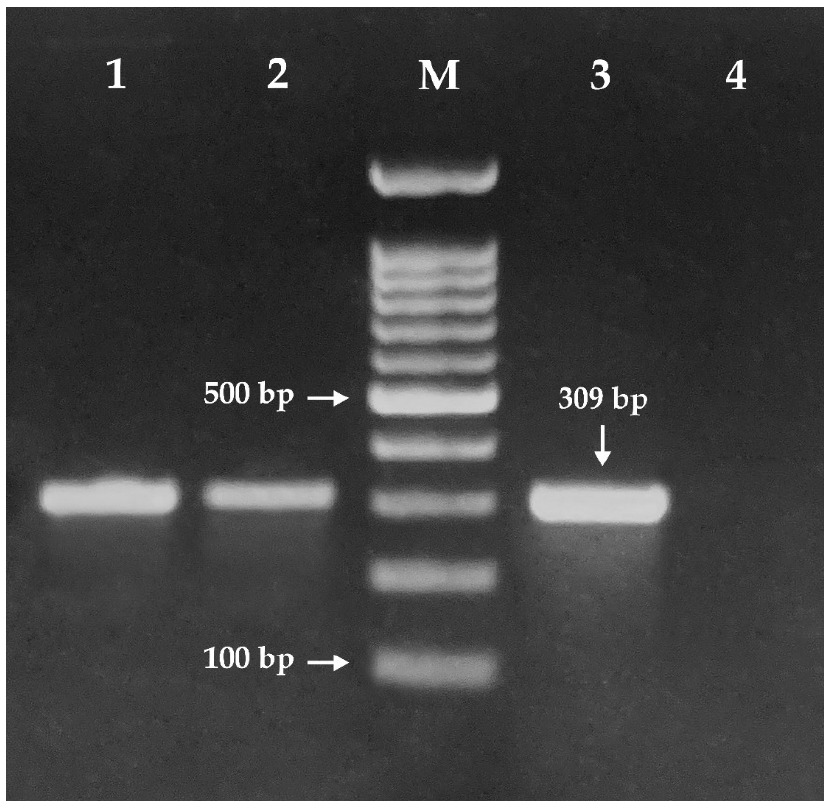
Figure 2. Agarose gel showing PCR amplification of mcr-1 gene in three E. coli strains isolated from urinary tract infections. Lane M: DNA molecular weight marker (100-bp ladder). Lanes 1, 2 and 3 show the amplicon (309 bp) of mcr-1 gene corresponding to EC13049, EC14142 and EC13655, respectively. Lane 4 exhibits the negative control ( E. coli , ATCC 25922). Table 2. Antimicrobial resistance profile of colistin-resistant E. coli clinical isolates and their transconjugants. E . coli Isolates